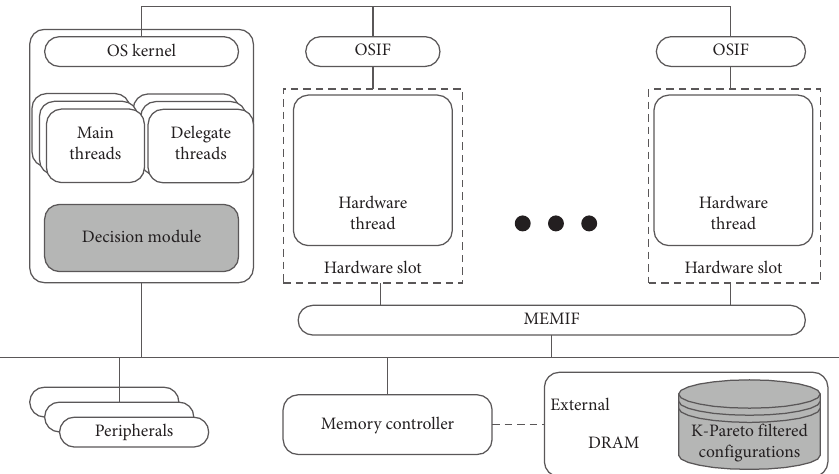
Figure 9: Exemplary ReconOS